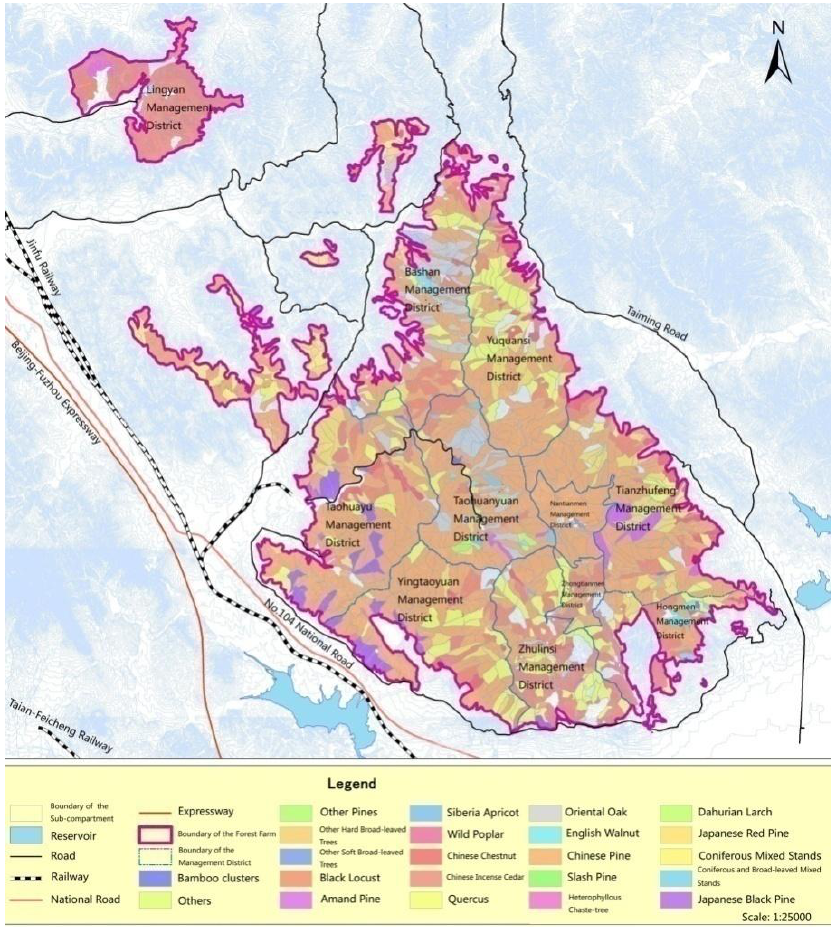
Figure 1. Tree species distribution map of Mount Taishan.